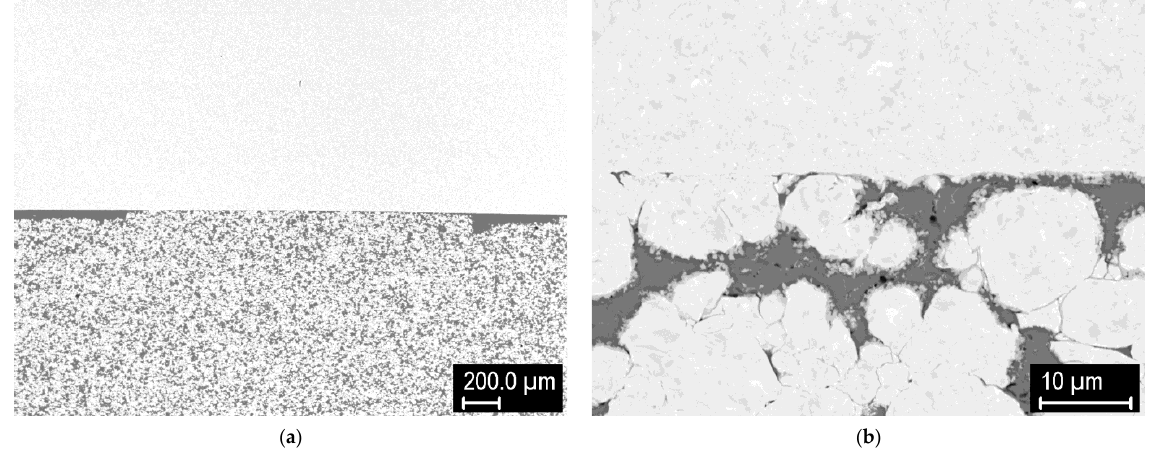
Figure 15. Tungsten-steel joint with a 60/40 mixed and lightly milled interlayer, joined at 1100 °C. ( a ) overview; ( b ) detail of the tungsten-composite interface.